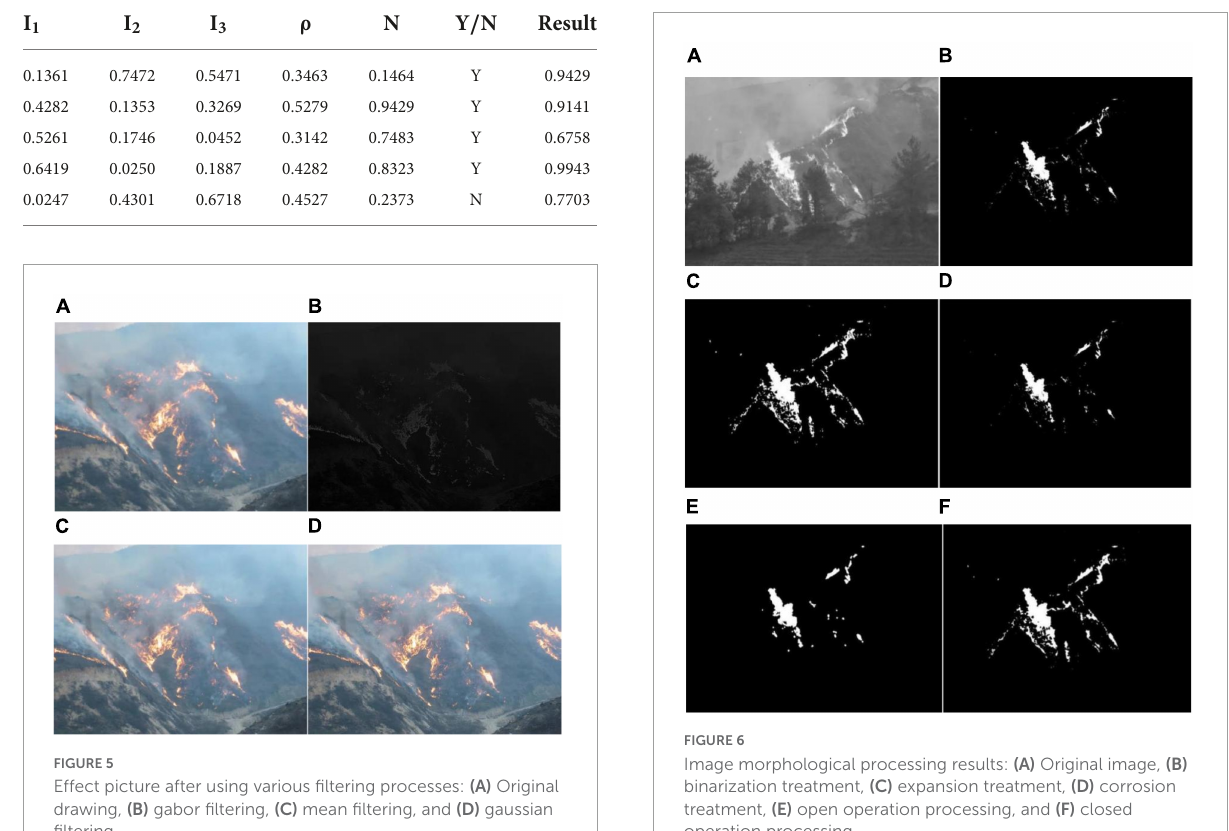
TABLE 2 Training sample.